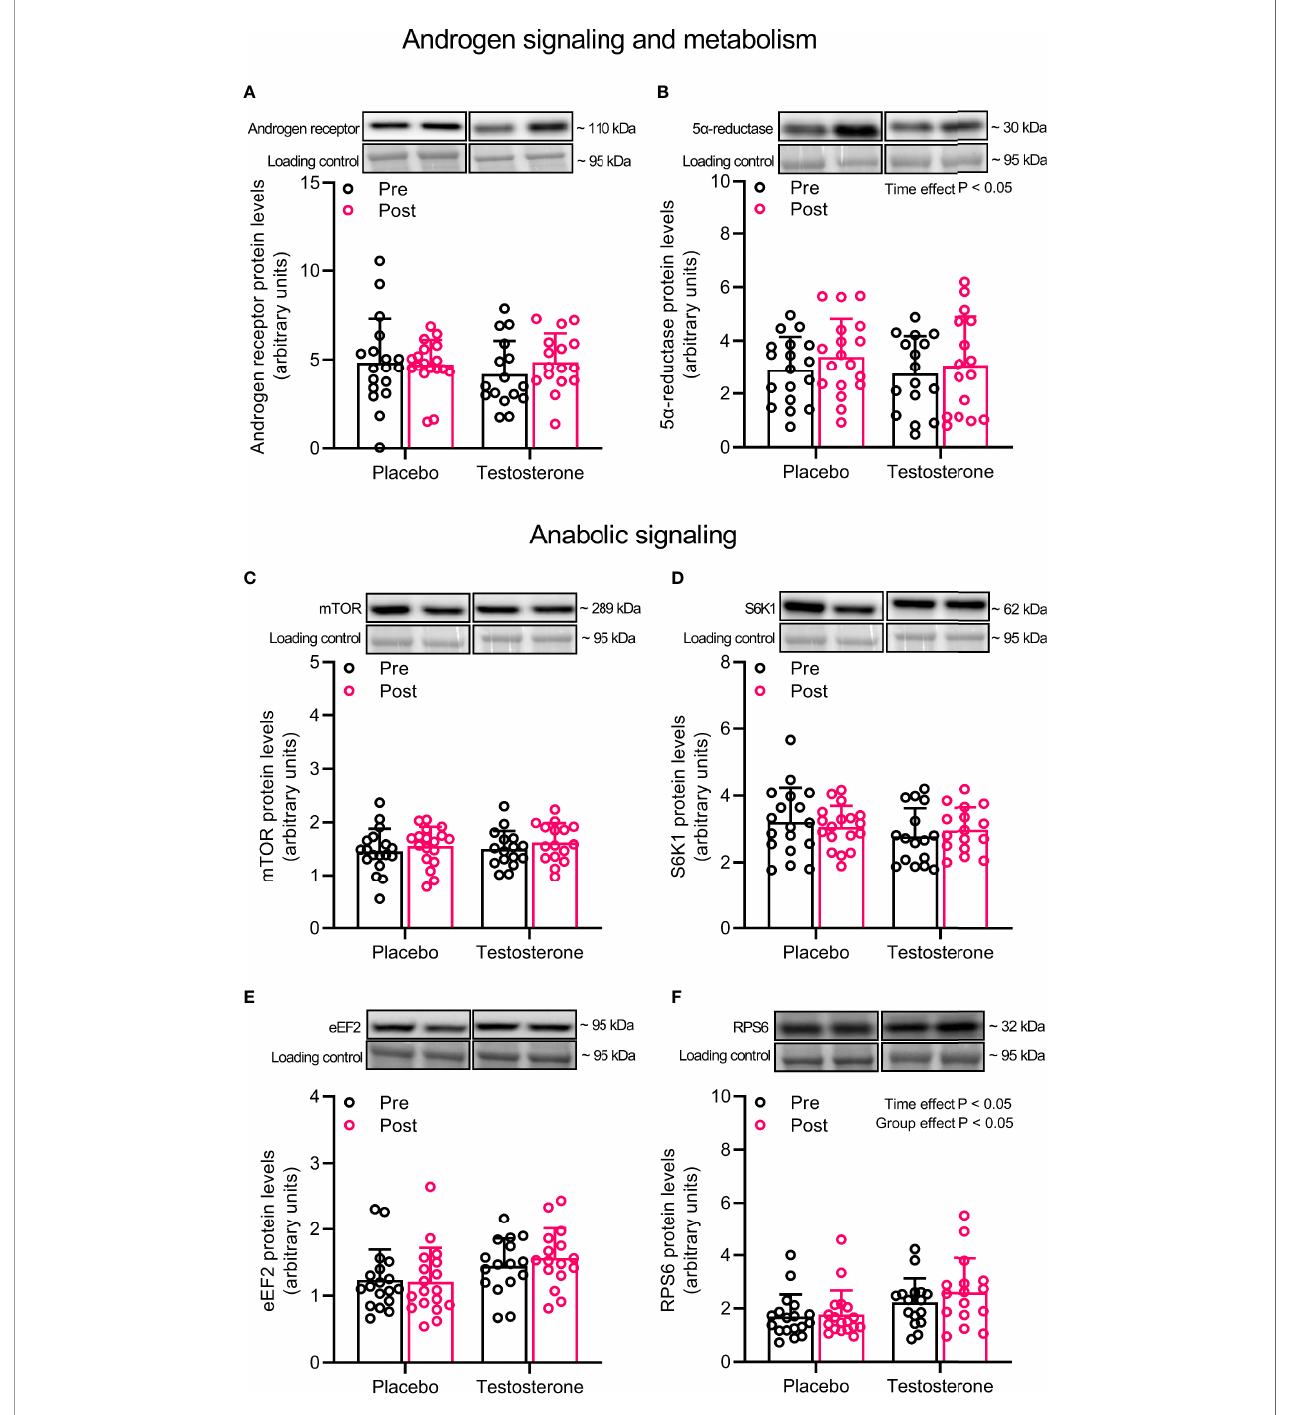
FIGURE 1 | Protein levels of androgen receptor (A) , 5 a -reductase (B) , mTOR (C) , S6K1 (D) , eEF2 (E) and RPS6 (F) before (black dots) and after the intervention (red dots). Representative blots for each individual protein target are shown above each graph. Loading control is represented by a band at ~ 95 kDa from the corresponding total protein stain (Memcode ™ ). The values presented are means ± SD and individual data points from 18 and 16 individuals (DF 32) in the placebo group and T group, respectively. The ANOVA revealed a signi fi cant main effect of time with respect to changes in protein levels for 5 a -reductase and a signi fi cant main effect of time and group for